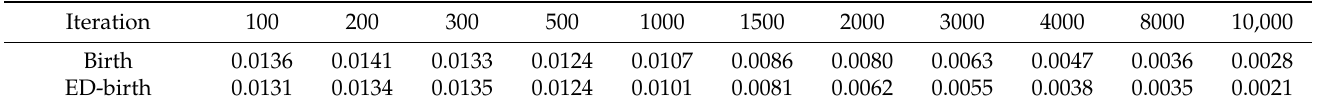
Table 3. The specific value of network structure variance (Globally Coupled